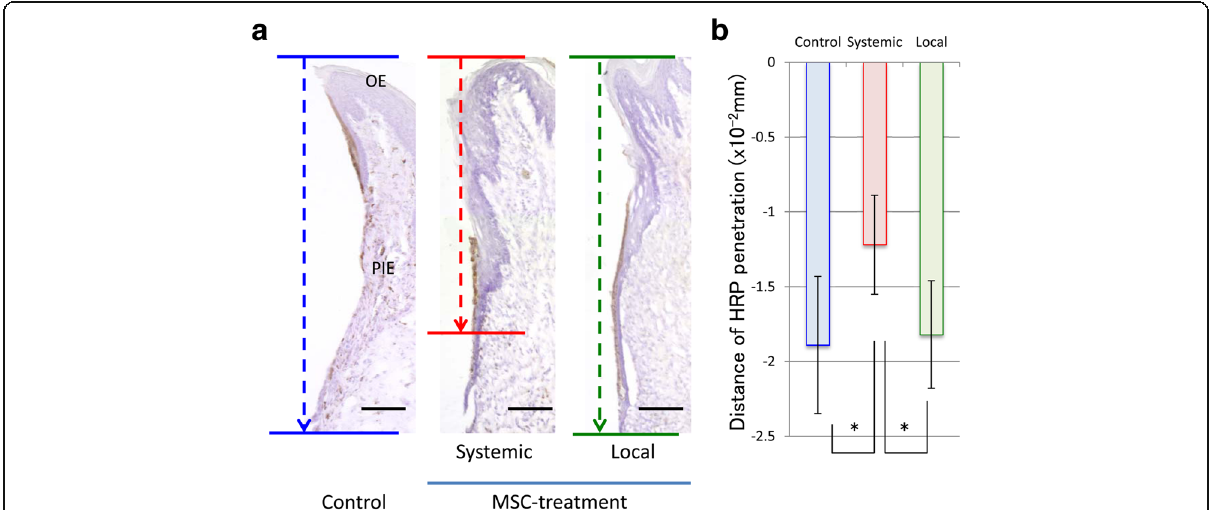
Fig. 2 HRP penetration on implant surface . a Light micrographs of the epithelial structure around the control, local, and systemic group implants after HRP penetration. Bar = 200 μ m. b Median distance of HRP penetration. Each bar represents the mean ± SD of the three independent experiments. * p < 0.05 vs. Cont